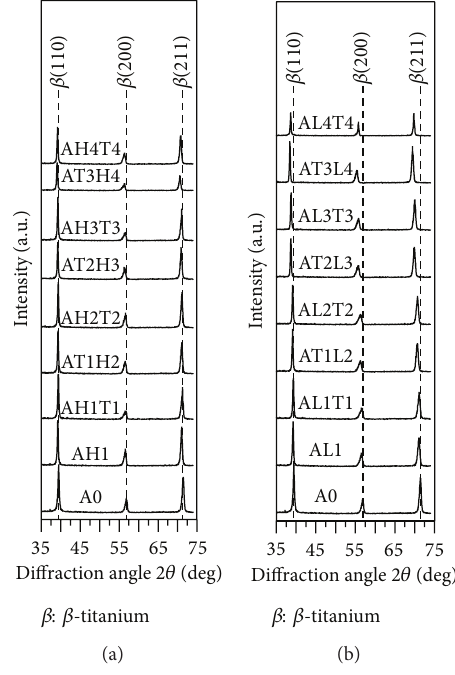
Figure8:XRDpatternsforspecimensaftersuccessive(a)BH j T l and (b) BL j T l